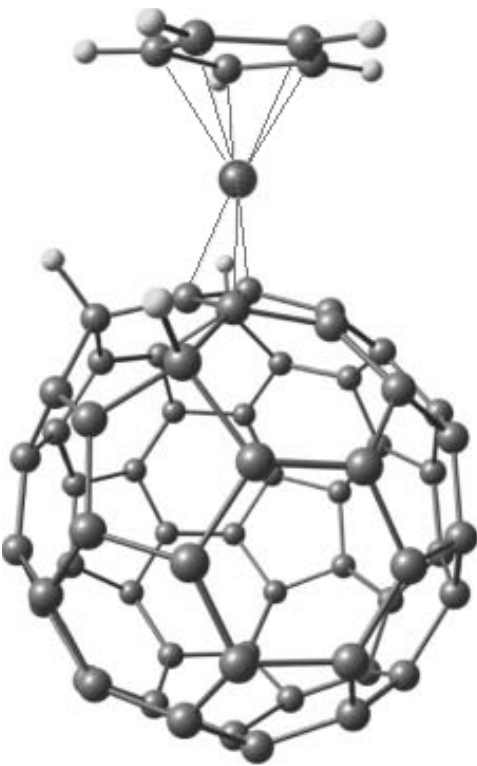
Figure 7. η 3 hapticity model